Question: Generate an informative caption for the figure above.
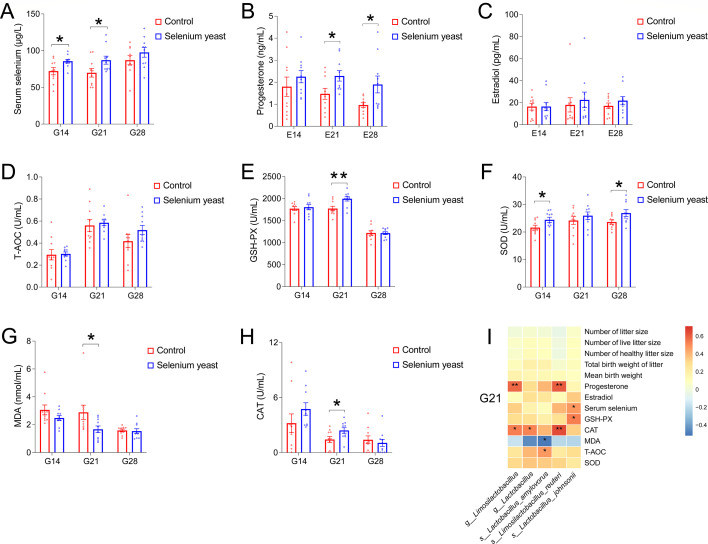
Answer: Impact of selenium yeast supplementation on selenium levels, reproductive hormones, and antioxidant capacity in sows. ( A ) Levels of selenium in serum. Levels of progesterone ( B ) and estradiol ( C ) in serum. Levels of T-AOC ( D ), GSH-Px ( E ), SOD ( F ), MDA ( G ), and CAT ( H ) in serum. ( I ) Correlation among intestinal microbiota, reproductive performance, selenium levels, reproductive hormones, and antioxidant-related indicators on gestation day 21. Correlation coefficients were analyzed using Spearman correlation analysis. Red color indicates positive correlation, and blue color indicates negative correlation. Statistical significance between groups was determined by unpaired Student’s t -tests ( A–H ). All data were presented as mean ± SEM ( A–H ). * P < 0.05, ** P < 0.01. n = 10.